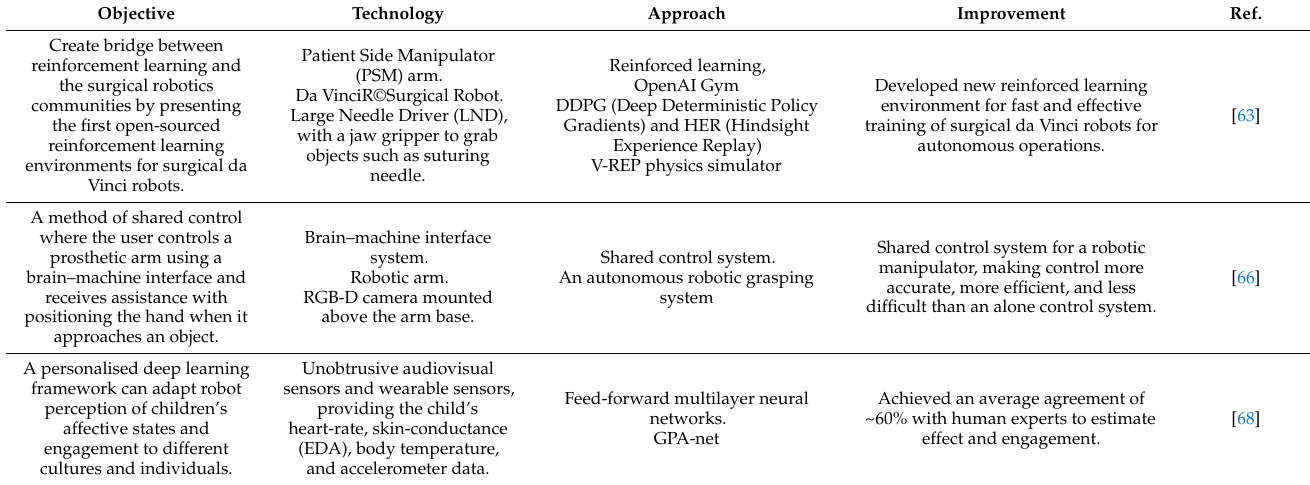
Table 4. Robotic solutions in medical